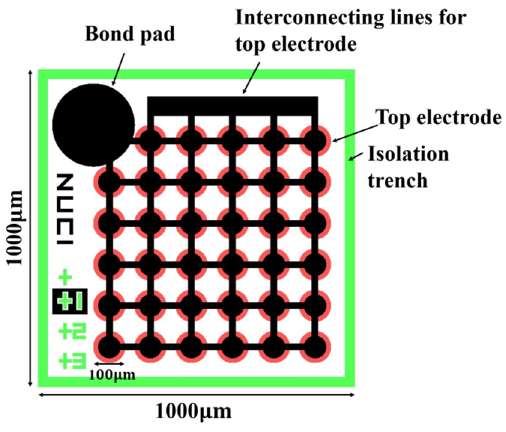
Figure 4. CMUT composite mask layout (35 cells).